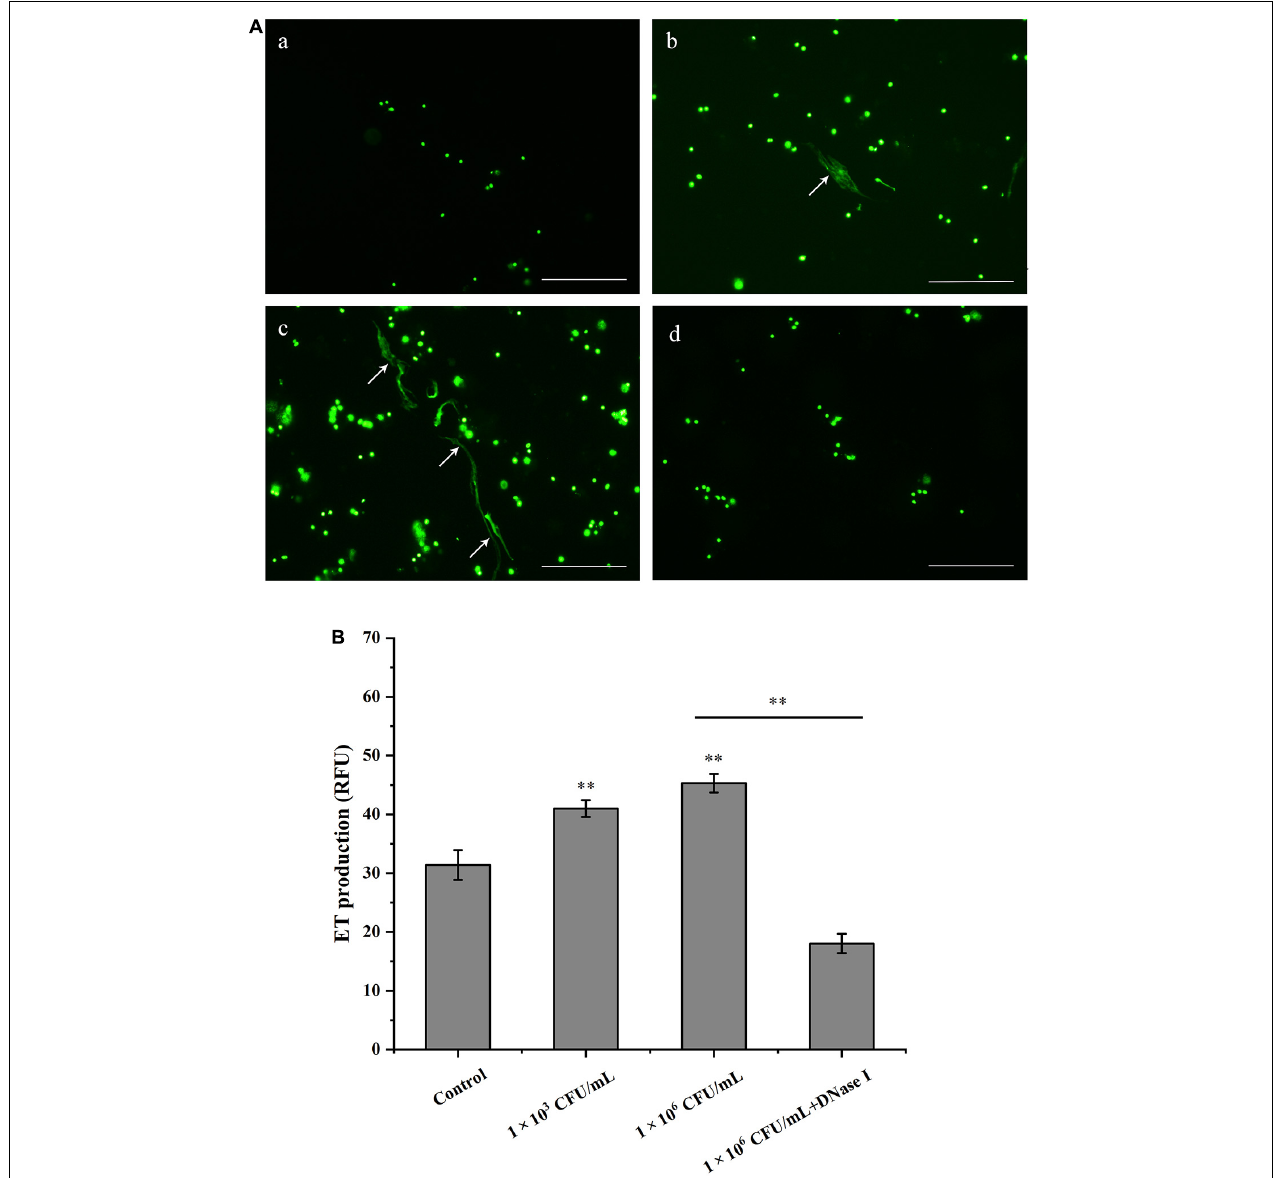
FIGURE 1 | Hemocytes release DNA in response to Vibrio parahaemolyticus stimulation. (A) V. parahaemolyticus induced ETs formation. Hemocytes treated with V. parahaemolyticus (1 × 10 3 and 1 × 10 6 CFU/mL) for 1 h. After SytoX staining for 5 min, the DNA released from hemocytes was observed using